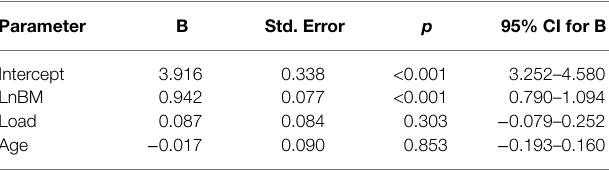
TABLE 3 | Parameter estimates and 95% CIs for the dependent variable, LnVO 2 during the repeated sprint protocol when body mass was used as covariate. Parameter B Std. Error p 95% CI for B Intercept